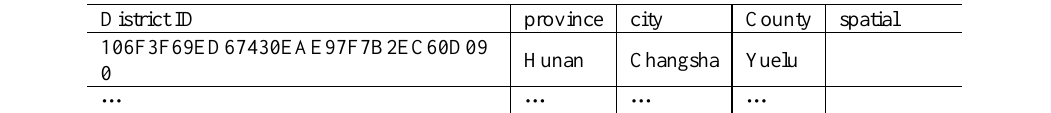
Table 2 National district distribution information